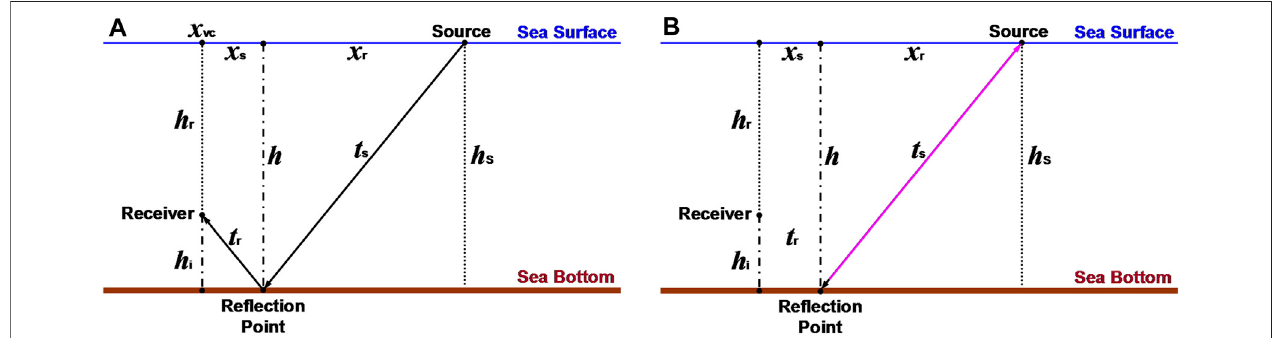
FIGURE 6 | The schematic diagram showing generation of CSP gathers from a common receiver gather. (A) The ray path in VCS geometry. (B) The sketch of common scatter point.